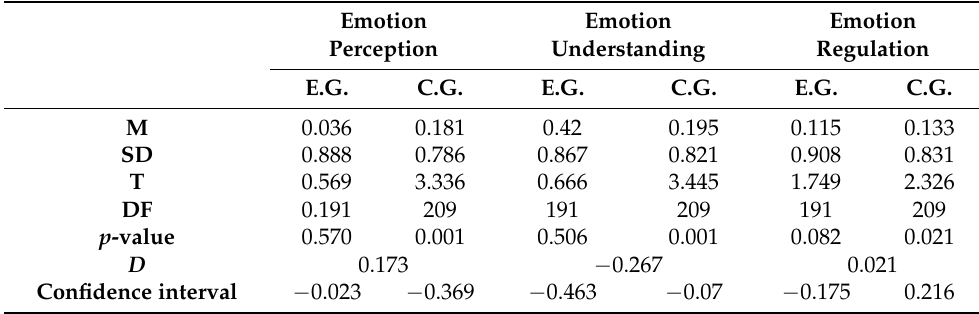
Table 5. Inferential analysis of the emotional intelligence (EI) of the EG and the CG in the pretest- posttest.